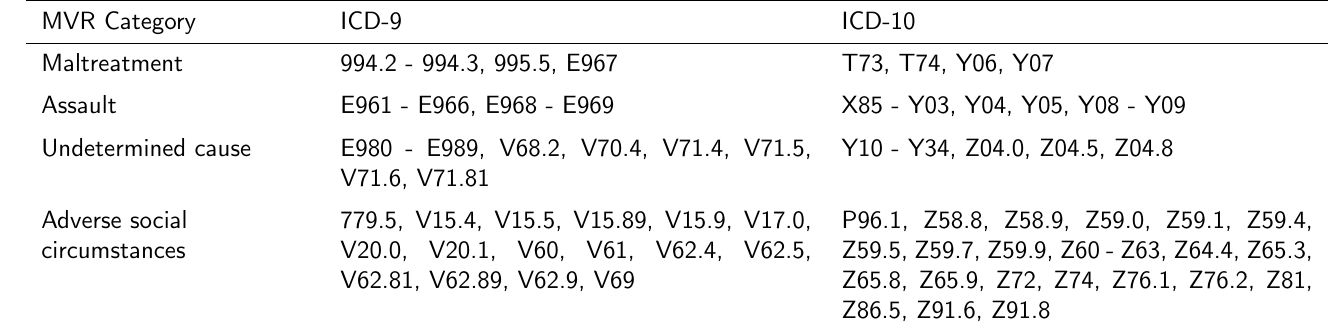
Table 2: Maltreatment or violence-related (MVR) codes compiled from Gilbert et al. (2012) and González-Izquierdo (personal communication,